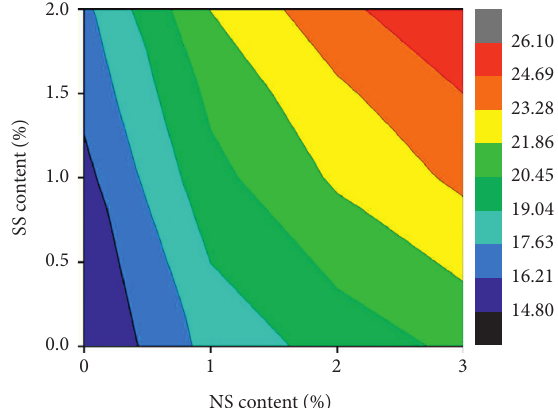
Figure 15: Effect of NS and SS on the compressive strength of HVFA mortars, reproduced from [125], with permission from Elsevier,